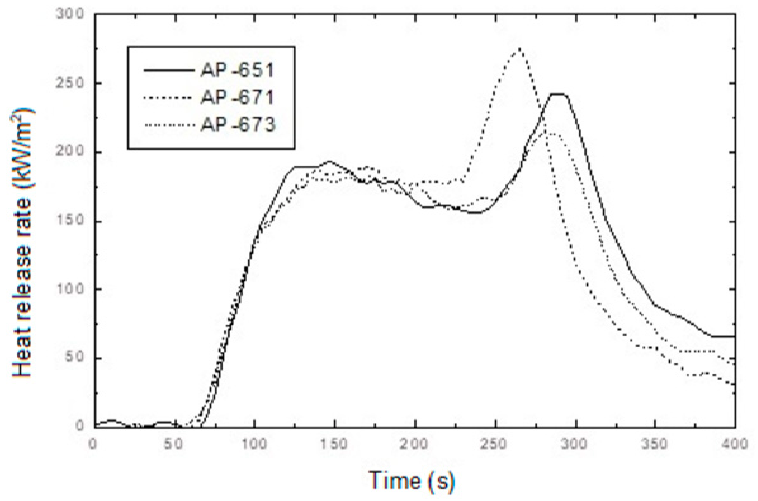
Figure 4. Flame retardancy of EVA/EXACT 8201/CLNA-8400/EBM/120 phr flame-retardant (MH+ZB) formulations as a function of additional RP content.